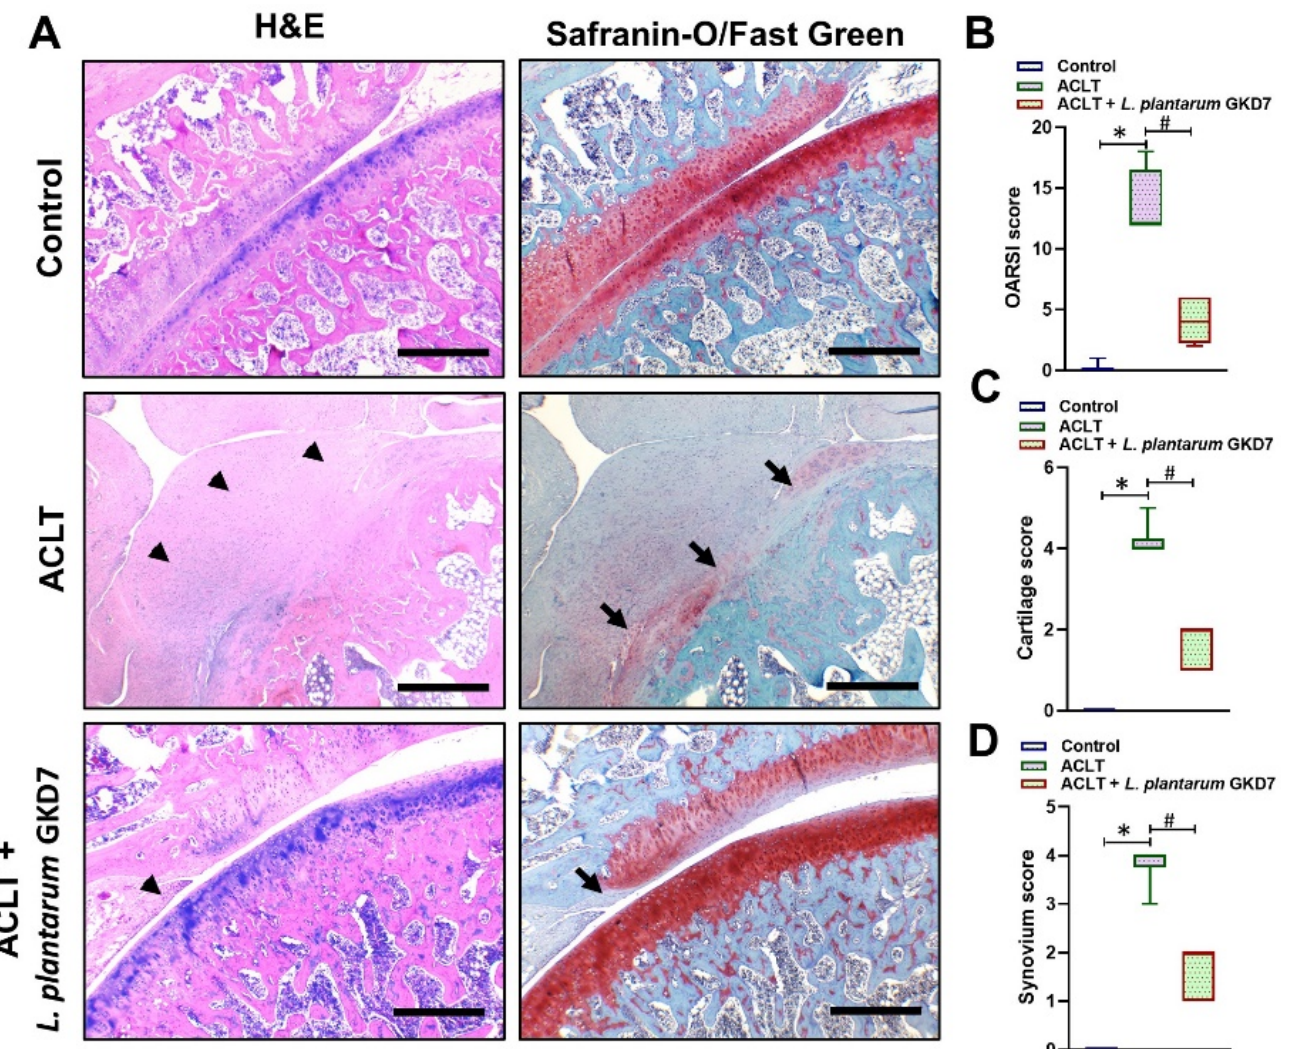
Figure 4. Histological evidence. ( A ) The images show representative knee joints from each group, consisting of coronal sections of articular cartilage stained with H&E and Safranin-O/Fast Green (magnification 5×). The arrowheads denote synovial hyperplasia and the arrows denote cartilage damage. Quantitative analyses of ( B ) OARSI scores, ( C ) cartilage scores, and ( D ) synovium scores. Scale bar = 500 µm. * p < 0.05 vs. controls; # p < 0.05 vs. the ACLT-only group.